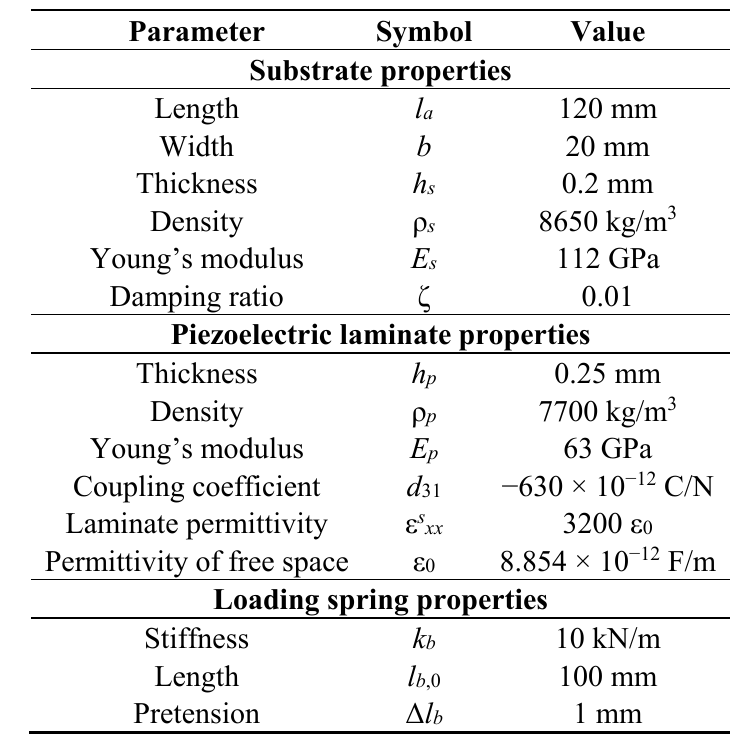
Table 1. Parameters of the